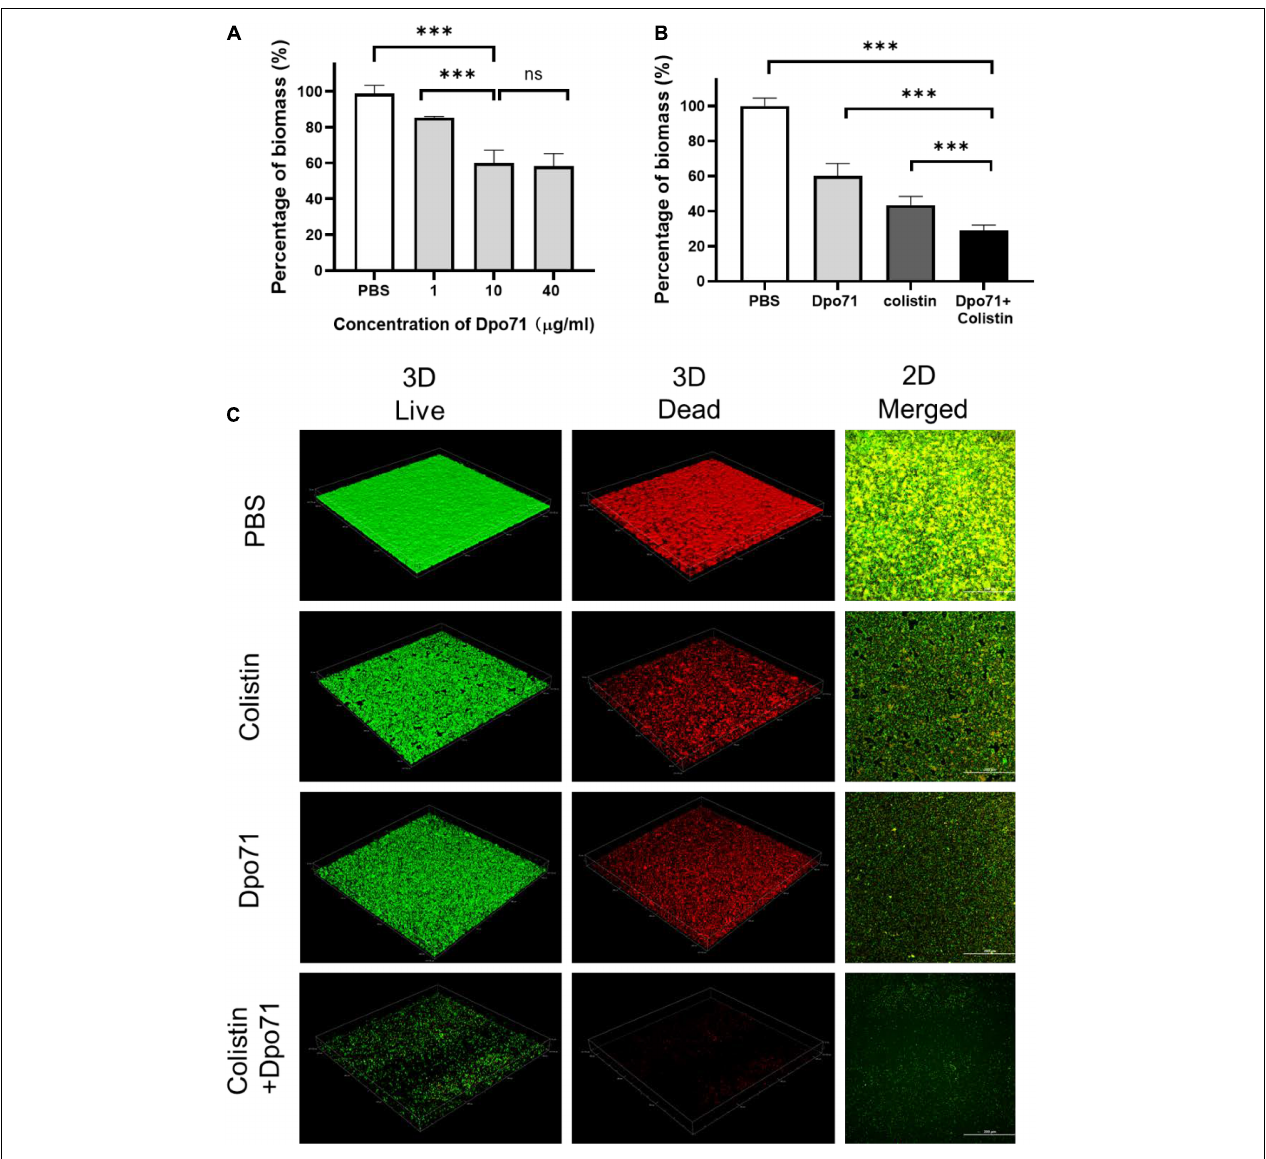
FIGURE 5 | Dpo71 and colistin inhibited biofilm formation. (A) Dpo71-alone inhibited the biofilm in a dose-dependent manner. (B) Dpo71 and colistin combination inhibited the biofilm formation. A. baumannii were incubated with PBS buffer; Dpo71; colistin (1 µ g/ml); and their combination agents (Dpo71 + colistin) in 96-well plates for 24 h, followed with crystal violet staining. The OD value of the PBS control was 1.55 ± 0.11. Data are expressed as means ± SD ( n = 3) with ∗∗∗ p < 0.001 determined by Student’s t -test. (C) The Representative confocal fluorescence microscopic images of LIVE/DEAD stained A. baumannii biofilm (Scale bar, 200 µ m). ns: No significant